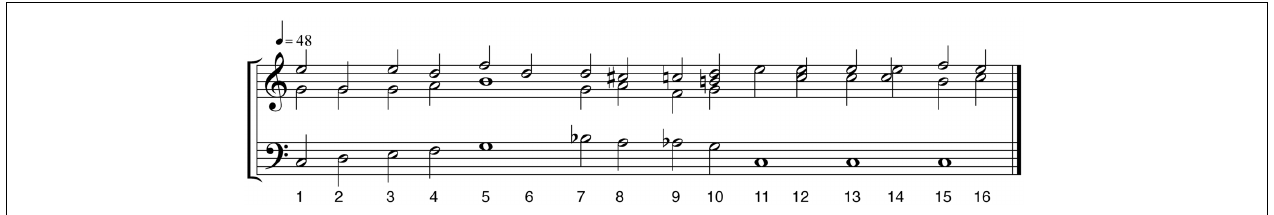
FIGURE 1 | Harmonic reduction of Schubert’s Morgengruss by Lerdahl (2013). Chord numbers (not measure numbers) are indicated below the